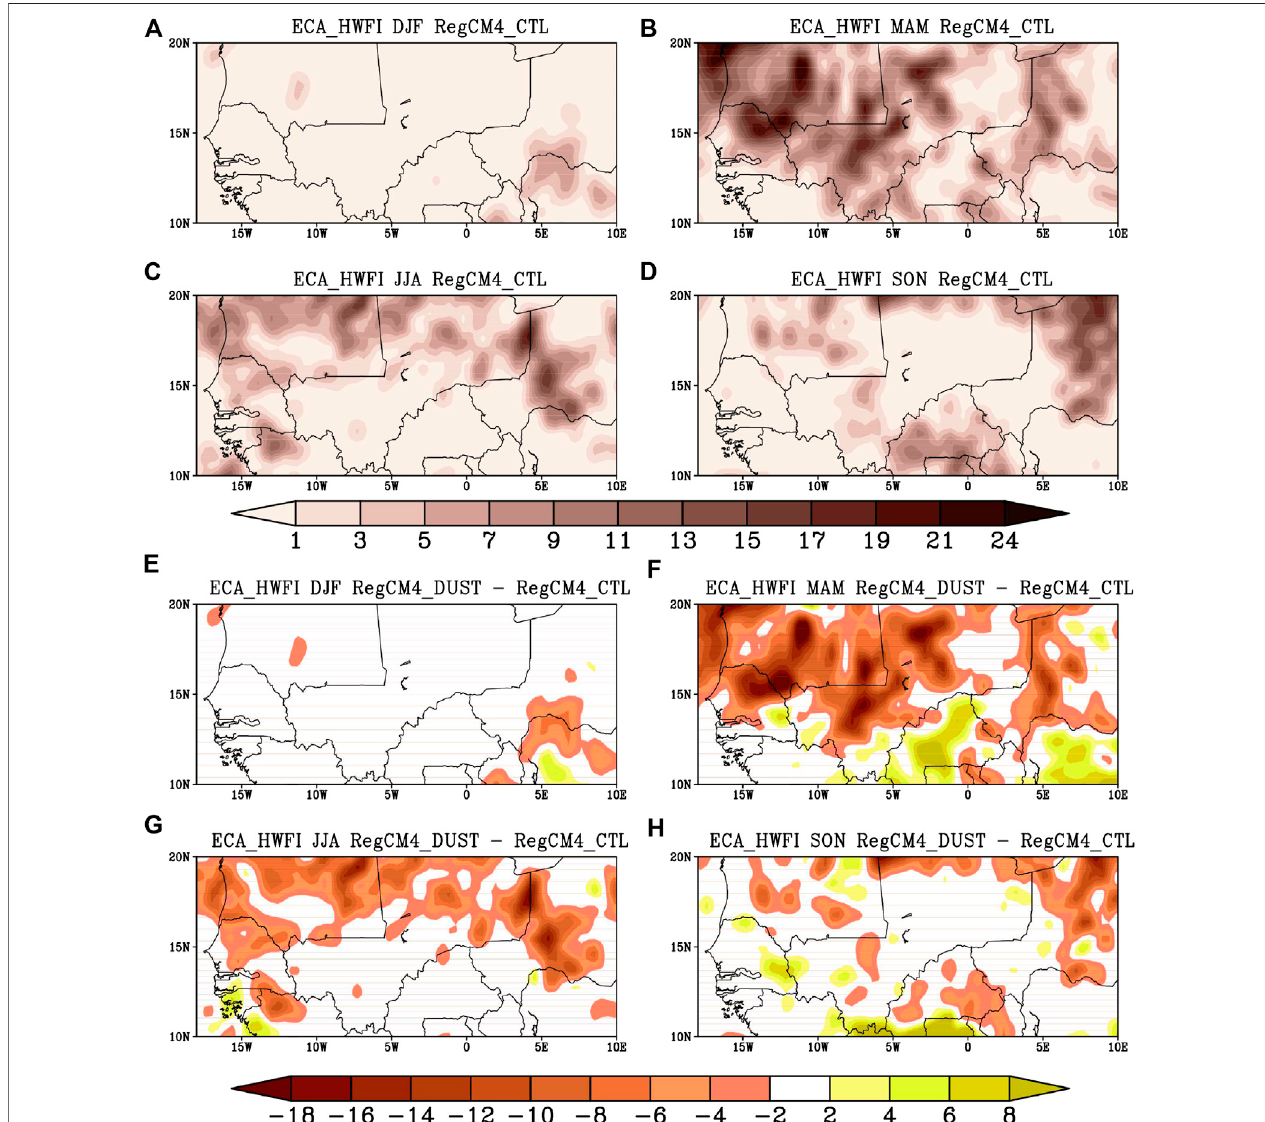
FIGURE 9 | Seasonal variability of warm spell days (ECA_HWFI) averaged from 2001 to 2010 over the Sahel: (top) RegCM4_CTL, (down) difference between RegCM4_DUST and RegCM4_CTL. The differences are signi fi cant at 95% level using the Student test.